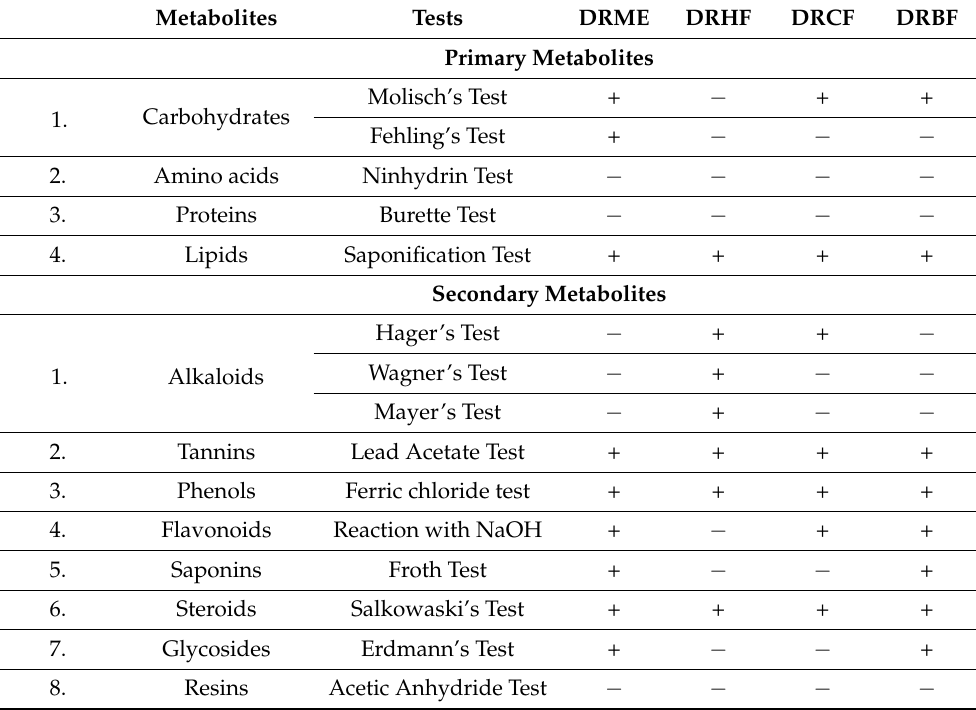
Table 1. Phytochemical analysis of extracts/fractions of Dracaena reflexa .